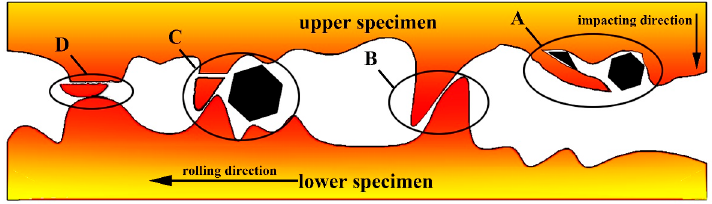
Figure 9. Schematic illustration of the wear mechanism.